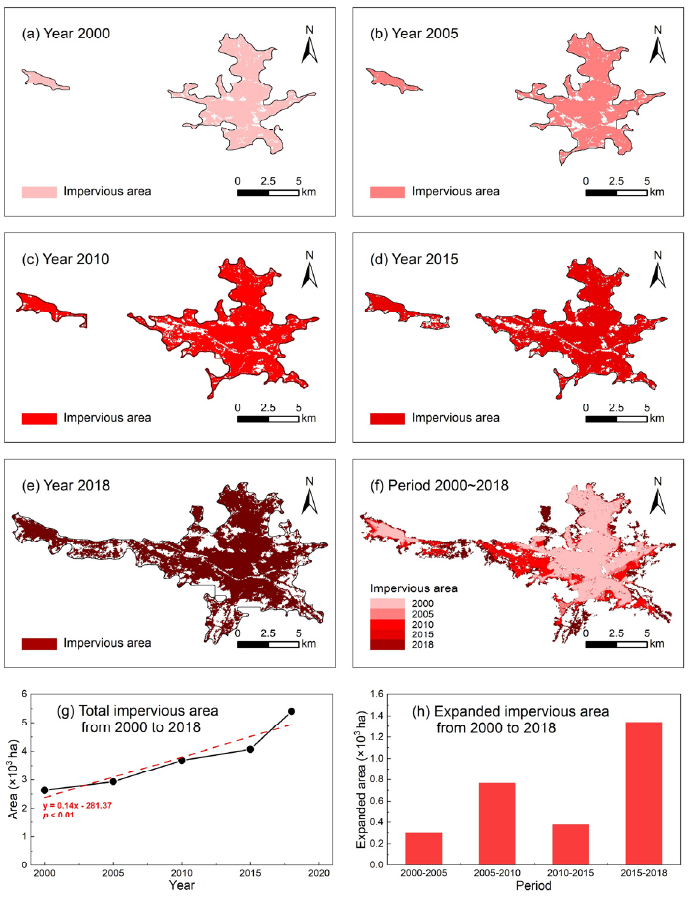
Figure 4. The spatiotemporal change in urban areas in Liaoyuan from 2000 to 2018. Panels ( a – f ) show the spatiotemporal change of impervious areas from 2000 to 2018. Panels ( g , h ) show the numerical change of impervious areas from 2000 to 2018.